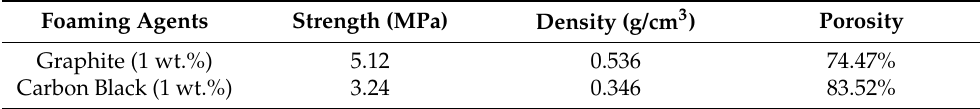
Table 2. Comparison of two allotropes of carbon as foaming agents. Foaming Agents Strength (MPa) Density (g/cm 3 ) Porosity Graphite (1 wt.%) Carbon Black (1